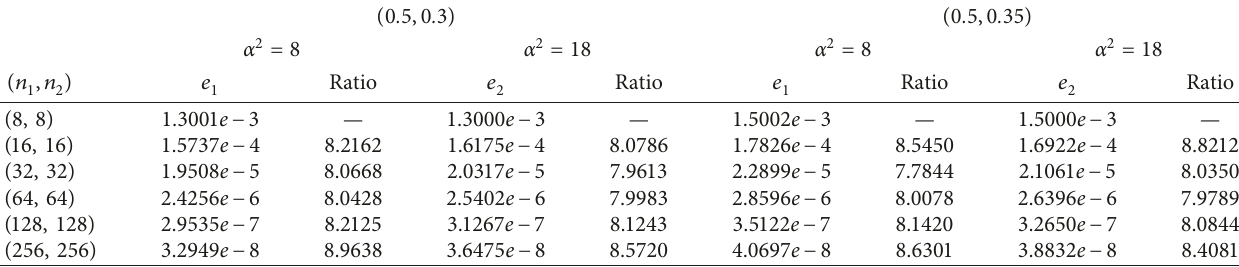
Table 1: The simulation results for Example 1.